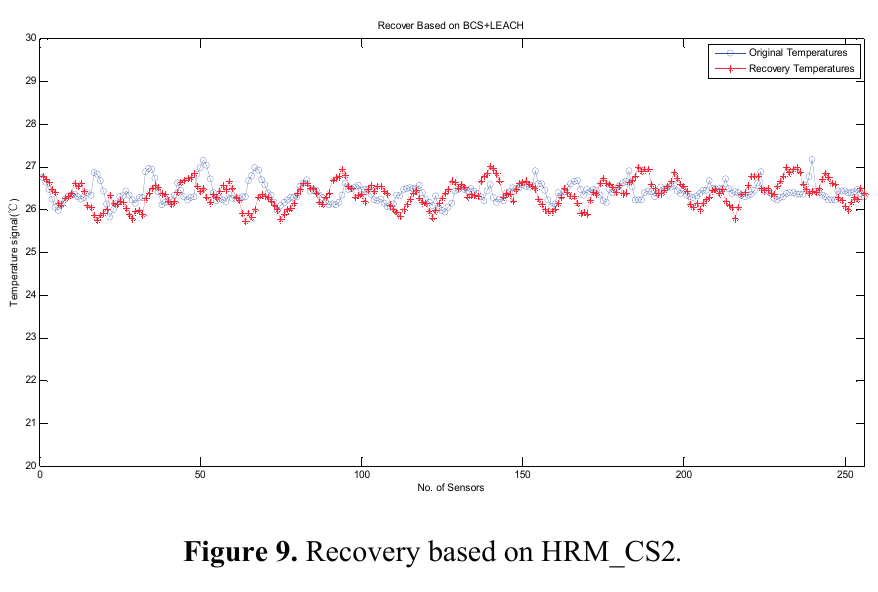
Figure 8. Recovery based on HRM_CS1 .